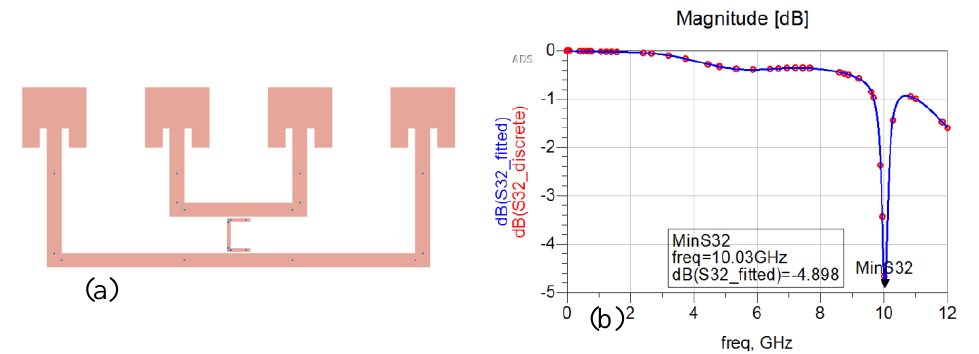
Figure 12. ( a ) Single-bit chipless linear Van Atta array composed by four elements with a single C resonator. ( b ) Simulated backscattered response in the X band (8GHz–12GHz).